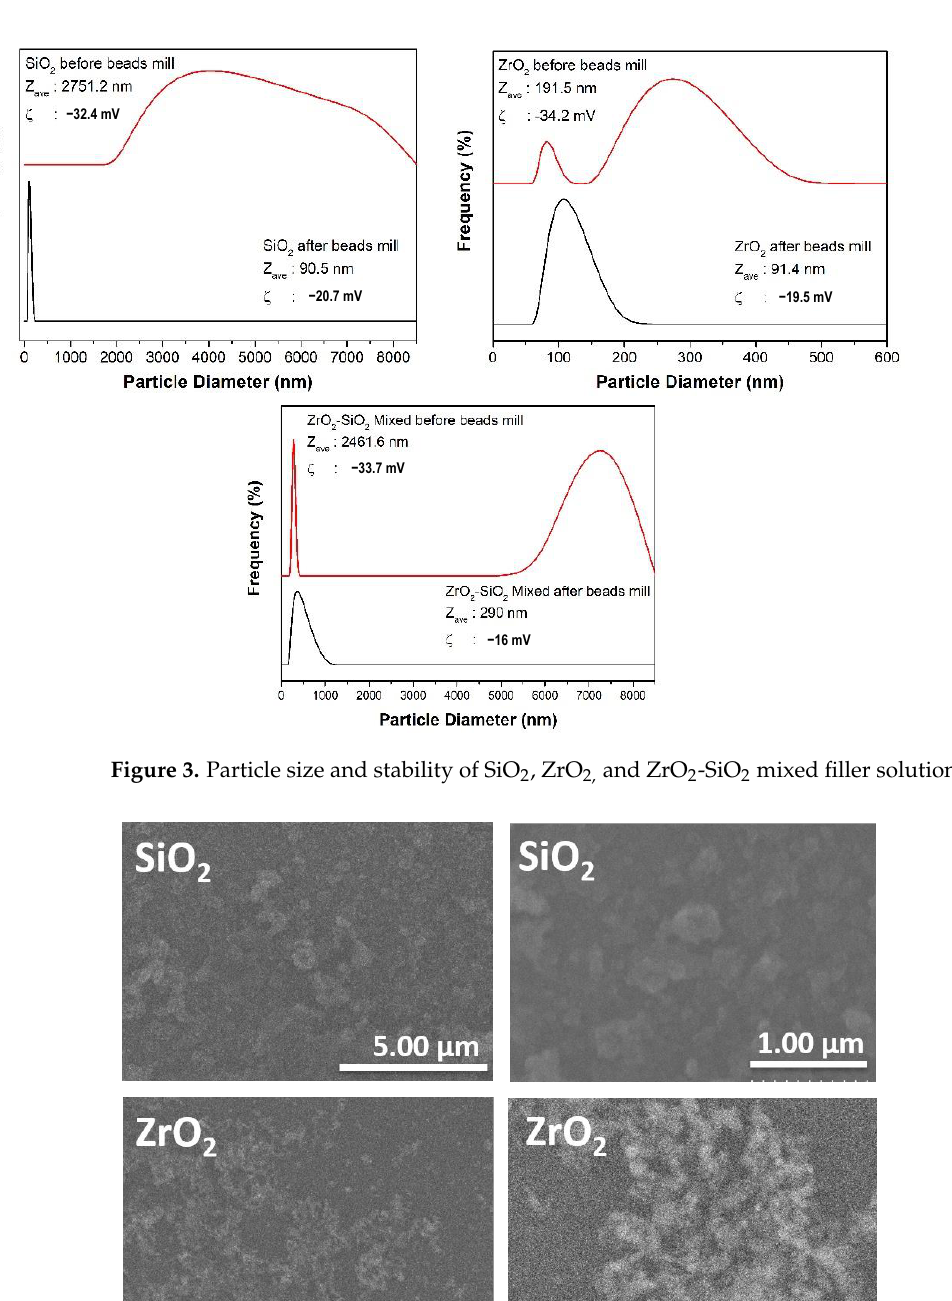
Figure 5. The Size Distribution of SiO 2 , ZrO 2, and ZrO 2 -SiO 2 mixed fillers.